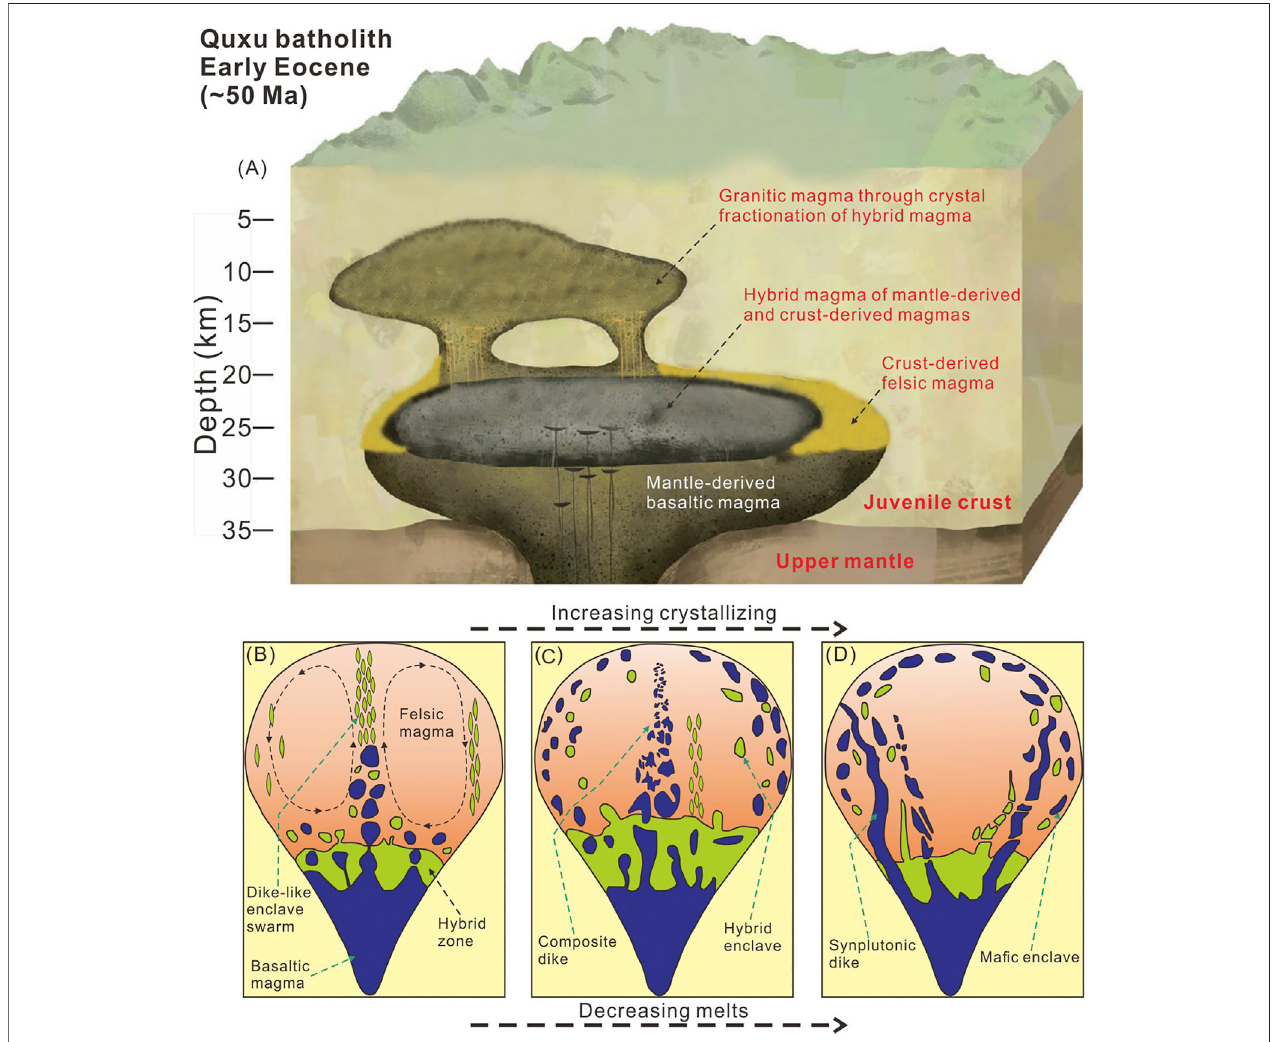
FIGURE 15 | Proposed model for the formation processes of multiple stages of magma mixing/hybridizations. (A) Overview of the magma mixing at depth (modi fi ed from Bachmann and Huber (2016)). (B – D) Detailed illustration of the processes of magma hybridization and the various types of resulting enclaves and dikes (modi fi ed from Barbarin (2005), Jayananda et al. (2014)).